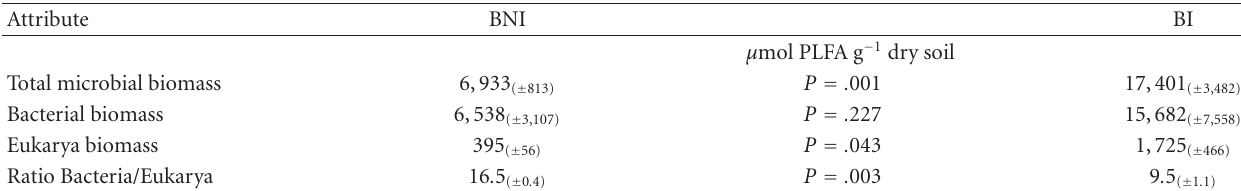
Table 2: Selected results of PLFA analyses for BNI and BI